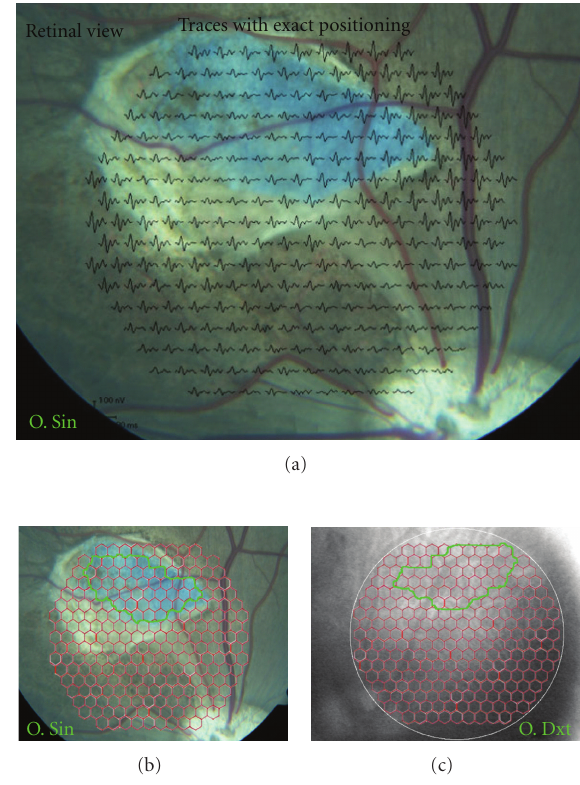
Figure 1: Fundus photos of both eyes 6 weeks after white PLGA transplantation. (a) Color fundus photo aligned with multifocal electroretinographic (mfERG) traces of the 241 unscaled stimulated hexagons. The bright reflective properties of the membranes are clearly visible. (b) Color fundus photo of the left membrane- transplanted eye aligned with hexagon grid used for mfERG recording. Area included as membrane is marked with a green line. (c) Infrared fundus photo of fellow right untouched eye with hexagon grid used for mfERG recording. The green line marks area included at membrane corresponding area for calculation of P1- amplitude ratio.